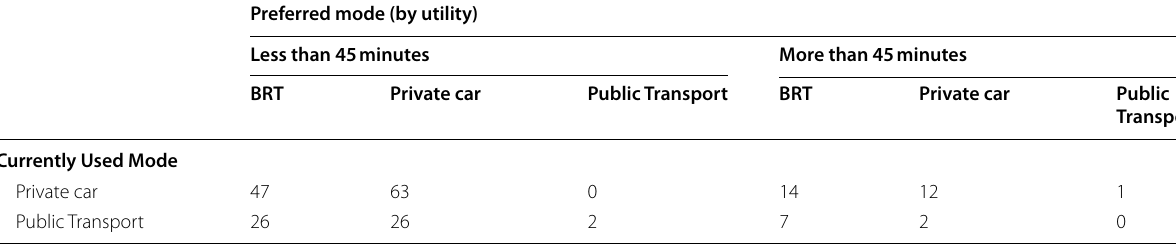
Table 5 Cross‑classification of actual and preferred transport modes with respect to travel duration Preferred mode (by utility)